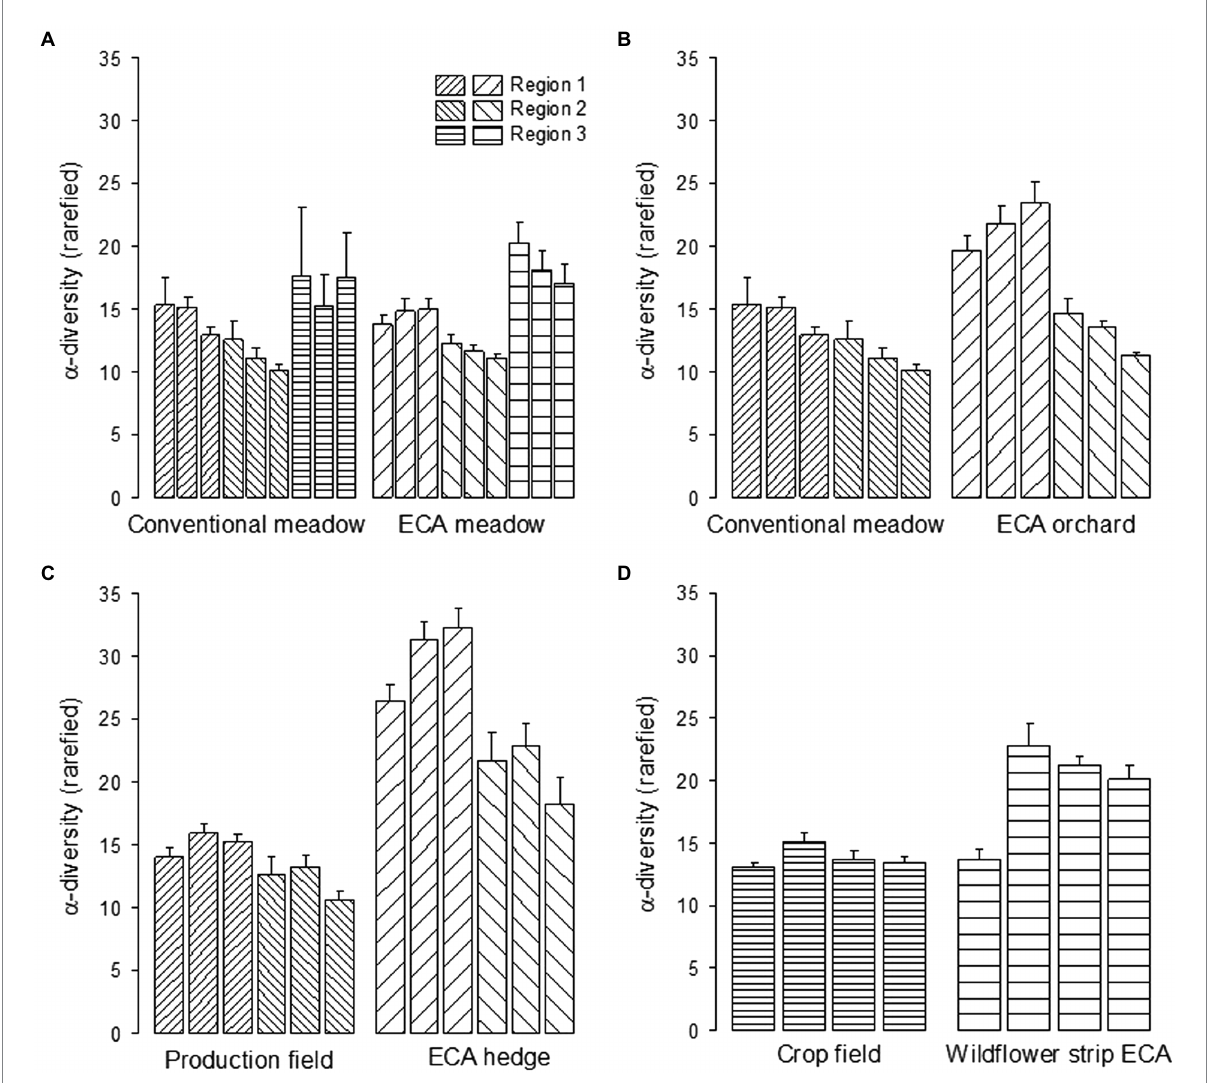
FIGURE 1 Alpha-diversity (mean number of species +1SE) of spider species (rarefied at 100 individuals) in BPAs and conventionally managed fields. Habitat types are compared by pairs, i.e., (A) BPA vs. conventional meadow, (B) BPA orchard vs. conventional meadow, (C) BPA hedge vs. production field (encompasses crop fields and conventional meadows without pastures), (D) wildflower strip BPA vs. crop field. The comparison of wildflower strip BPA vs. crop field occurs in region three only. Each bar represents alpha-diversity per year, i.e., 1999, 2001, 2003 from the left to the right (1997 in addition for crop field vs. wild flower strip BPA). The scale among graphs is kept the same to allow vertical